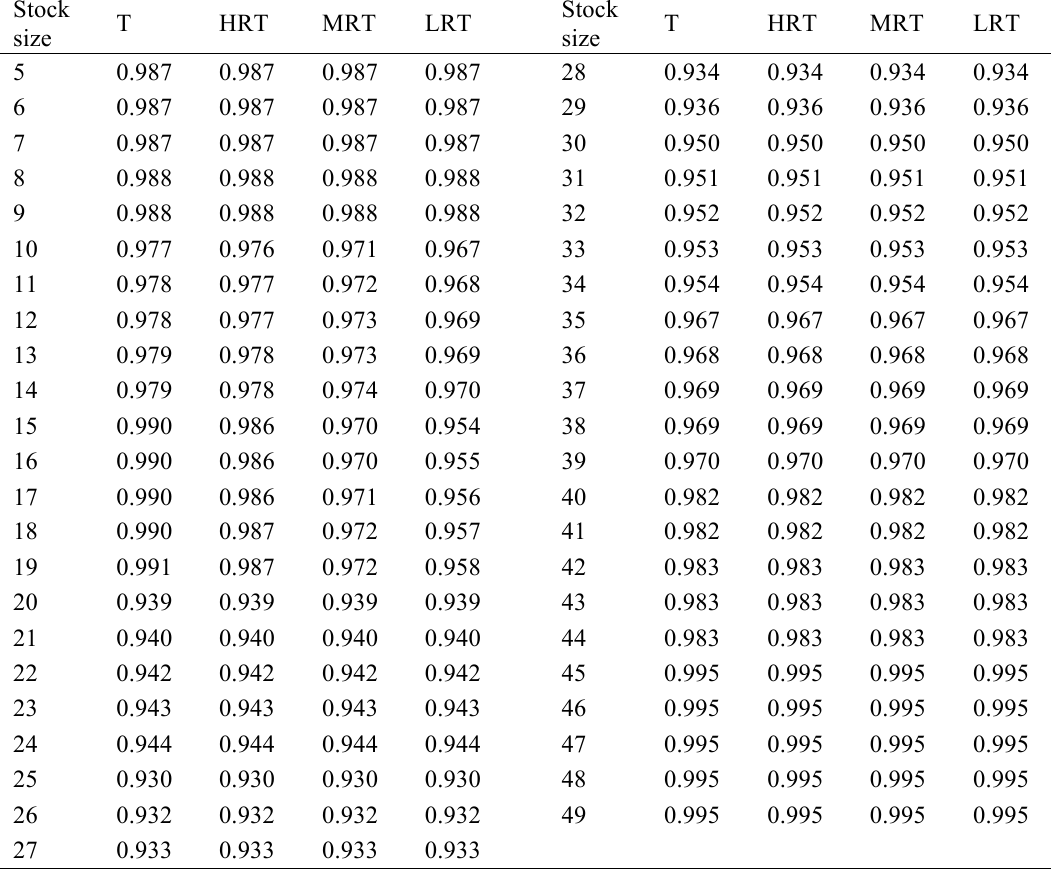
Table A6.1. Critical discount factors for all resource stock sizes for all four treatments.